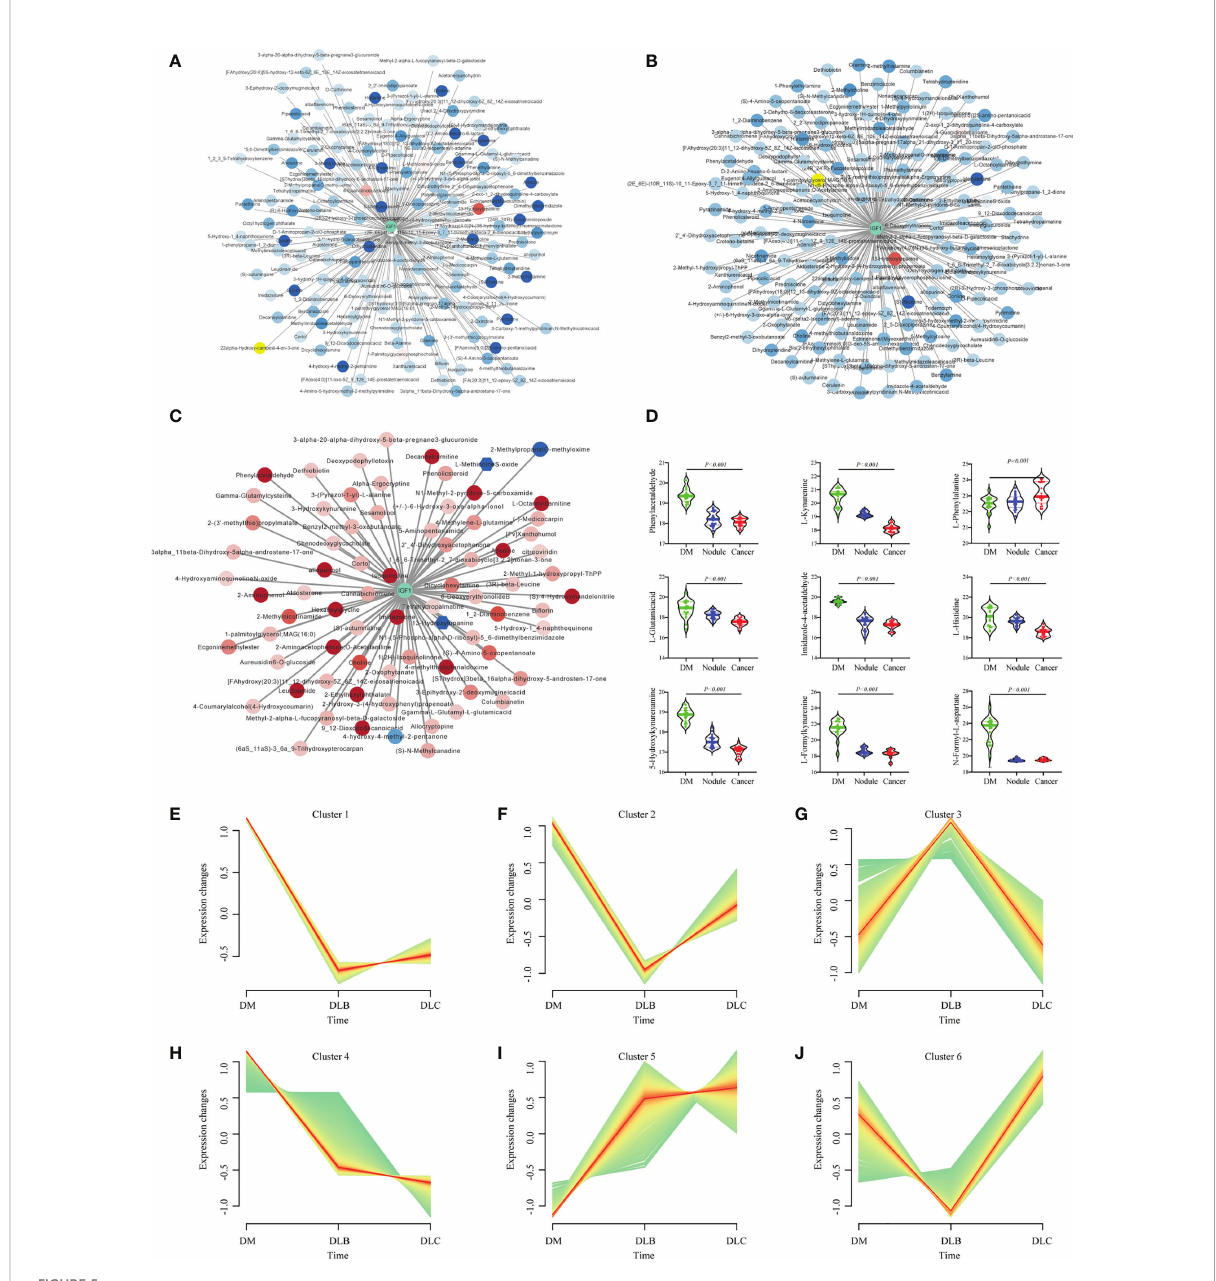
FIGURE 5 Networks of the IGF-1 and DEMs between DLC and DM (A) , Networks of the IGF-1 and DEMs between DLB (B) , Networks of the IGF-1 and DEMs between DLC and DLB (C) ; Representatives of the three groups (D) ; Different trend cluster of the DEMs among the three groups (E – J)